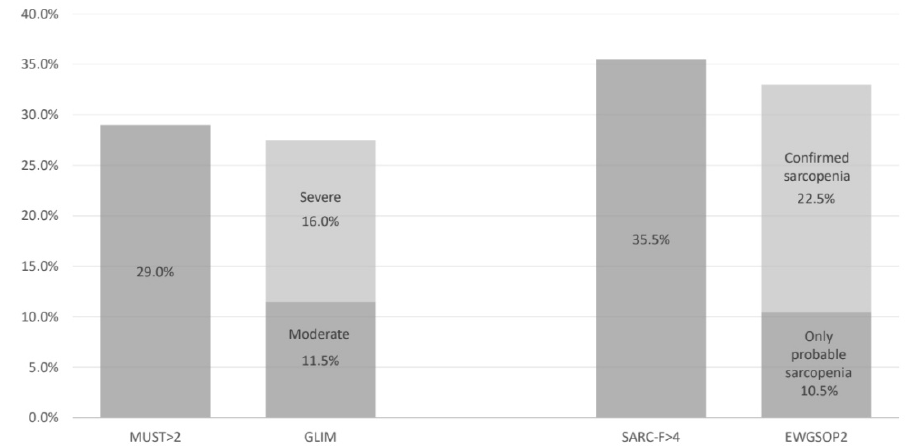
Figure 2. Screening and diagnosis of disease-related malnutrition and sarcopenia at admission. The phenotypic criterion in the GLIM consensus defined the severity of malnutrition, according to the cut-off points [1]. For sarcopenia diagnosed by EWGSOP2, low muscle function implies probable sarcopenia and low muscle mass confirmed sarcopenia [2]. MUST = malnutrition universal screening tool; a score > 2 indicates high risk of malnutrition. SARC-F = sarcopenia screening tool; a score > 4 indicates high risk of sarcopenia.